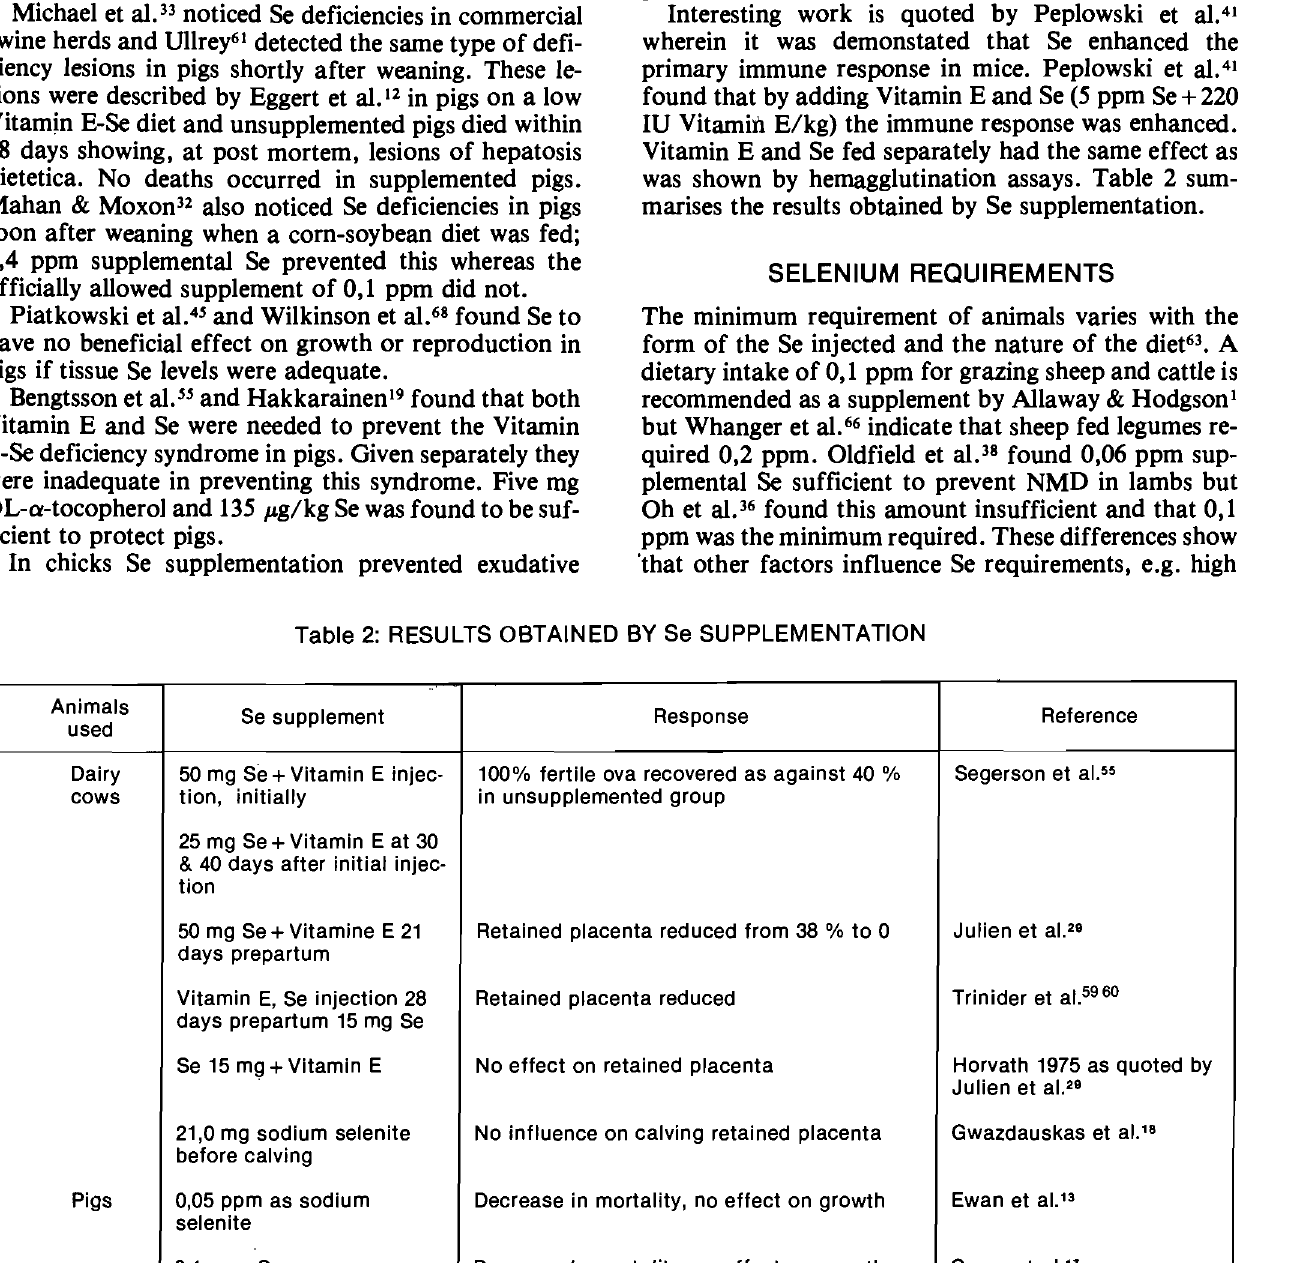
Table 2: RESULTS OBTAINED BY Se